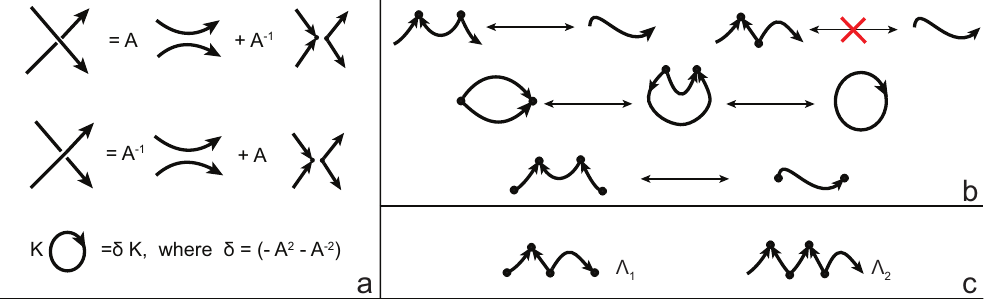
Figure 11. ( a ) Oriented state expansion; ( b ) Reduction rules for the arrow polynomial; and ( c ) a component with one ( Λ 1 ) and two zig-zags ( Λ 2 ),